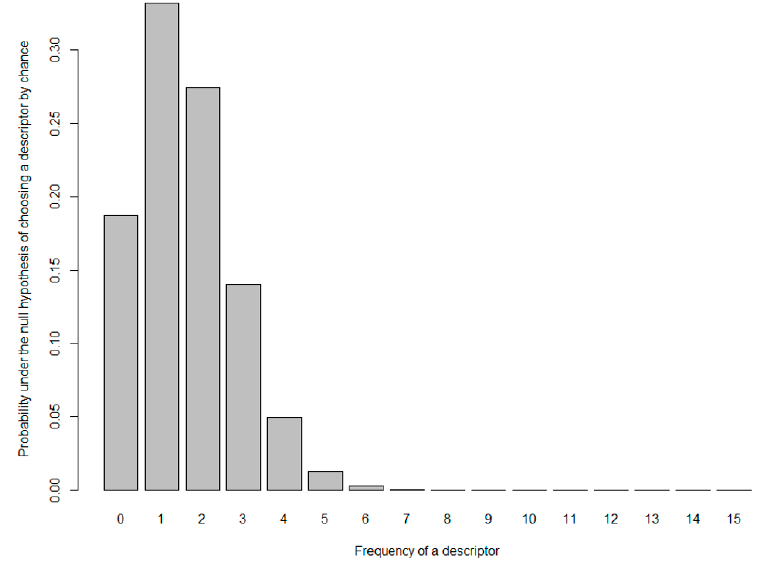
Figure 8. The expected probability distribution for the binomial with 15 trials (number of assessors) considering the probability of 10% of choosing a descriptor from the developed sensory